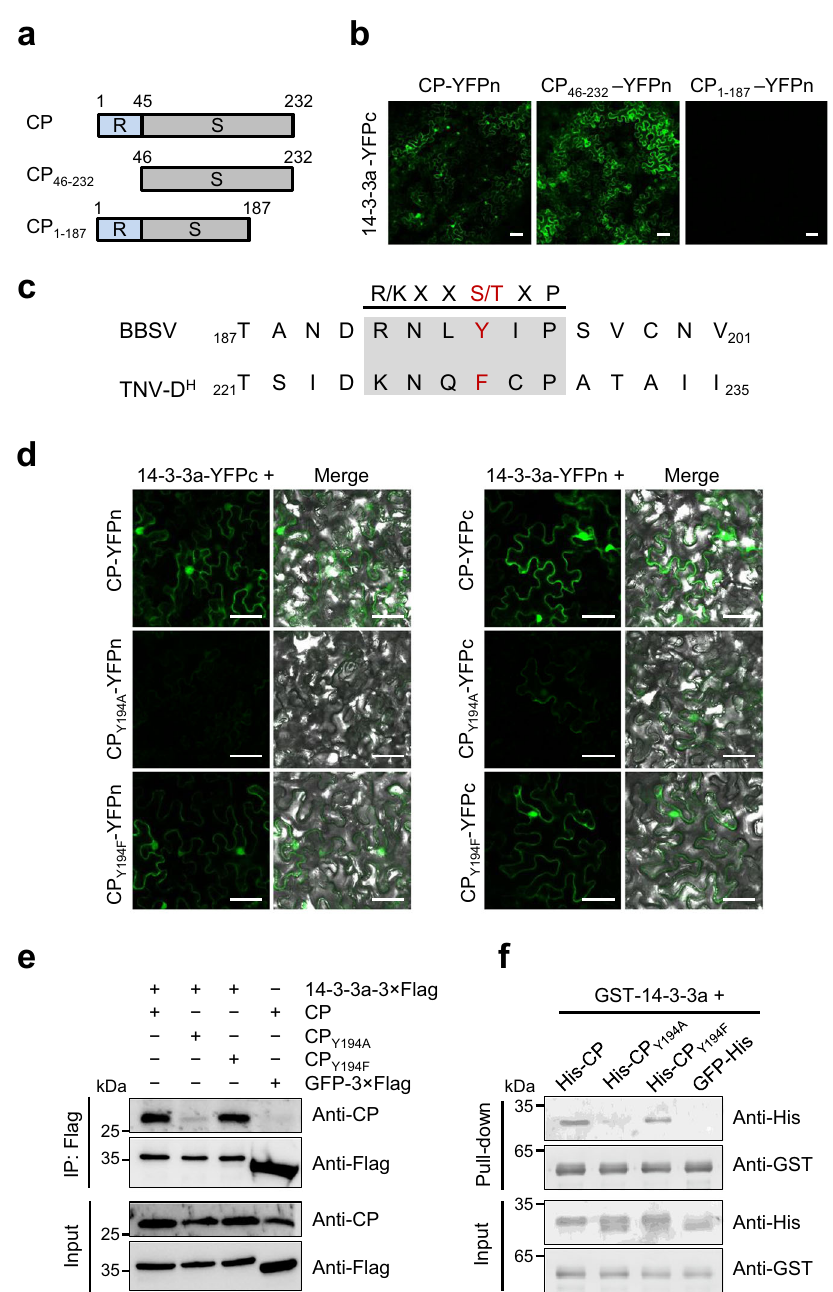
Fig. 6 Determination of key amino acids that are responsible for CP-14-3-3a interaction. a Schematic representation of CP truncated mutants used for BiFC assays. b BiFC analysis of regions within CP that interacted with 14-3-3a. Wild-type or truncated CP mutants fused to N-terminus of YFP and 14-3-3a fused to C-terminus were transiently co-expressed in N. benthamiana leaves. Confocal analysis was performed at 3 dpi. Representative results of at least three independent experiments are shown. Scale bars = 50 µ m. c Multiple sequence alignment of the C-terminus of CPs from Betanecroviruses. The 14-3- 3-binding-like motif is shaded in gray, and the putative 14-3-3-binding site is highlighted in red. d BiFC analysis of the interaction between wild-type or mutant CP and 14-3-3a. Wild-type or mutant CP and 14-3-3a fused to N or C-terminus of YFP were transiently co-expressed in N. benthamiana leaves. Confocal analysis was performed at 3 dpi. Representative results of at least three independent experiments are shown. Scale bars = 50 µ m. e Co-IP analysis of the interaction between wild-type or mutant CP and 14-3-3a. N. benthamiana leaves transiently expressing combinations of different proteins were harvested at 3 dpi. Total proteins were immunoprecipitated with anti-Flag beads and detected by western blot with an anti-CP or anti-Flag antibody. f GST pull-down assay to detect the interaction between wild-type or mutant CP and 14-3-3a. Puri fi ed His-tagged CP or its derivatives was incubated with GST-14-3-3a or GST protein. His-GFP protein served as the negative control. After incubation with glutathione-Sepharose beads, the pull-down products were analyzed by western blot with an anti-His or anti-GST antibody. For panels e and f , the experiments were repeated three times with similar